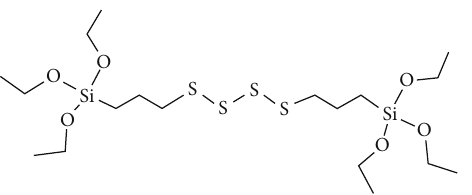
Figure 1: The chemical structure of silane coupling agent